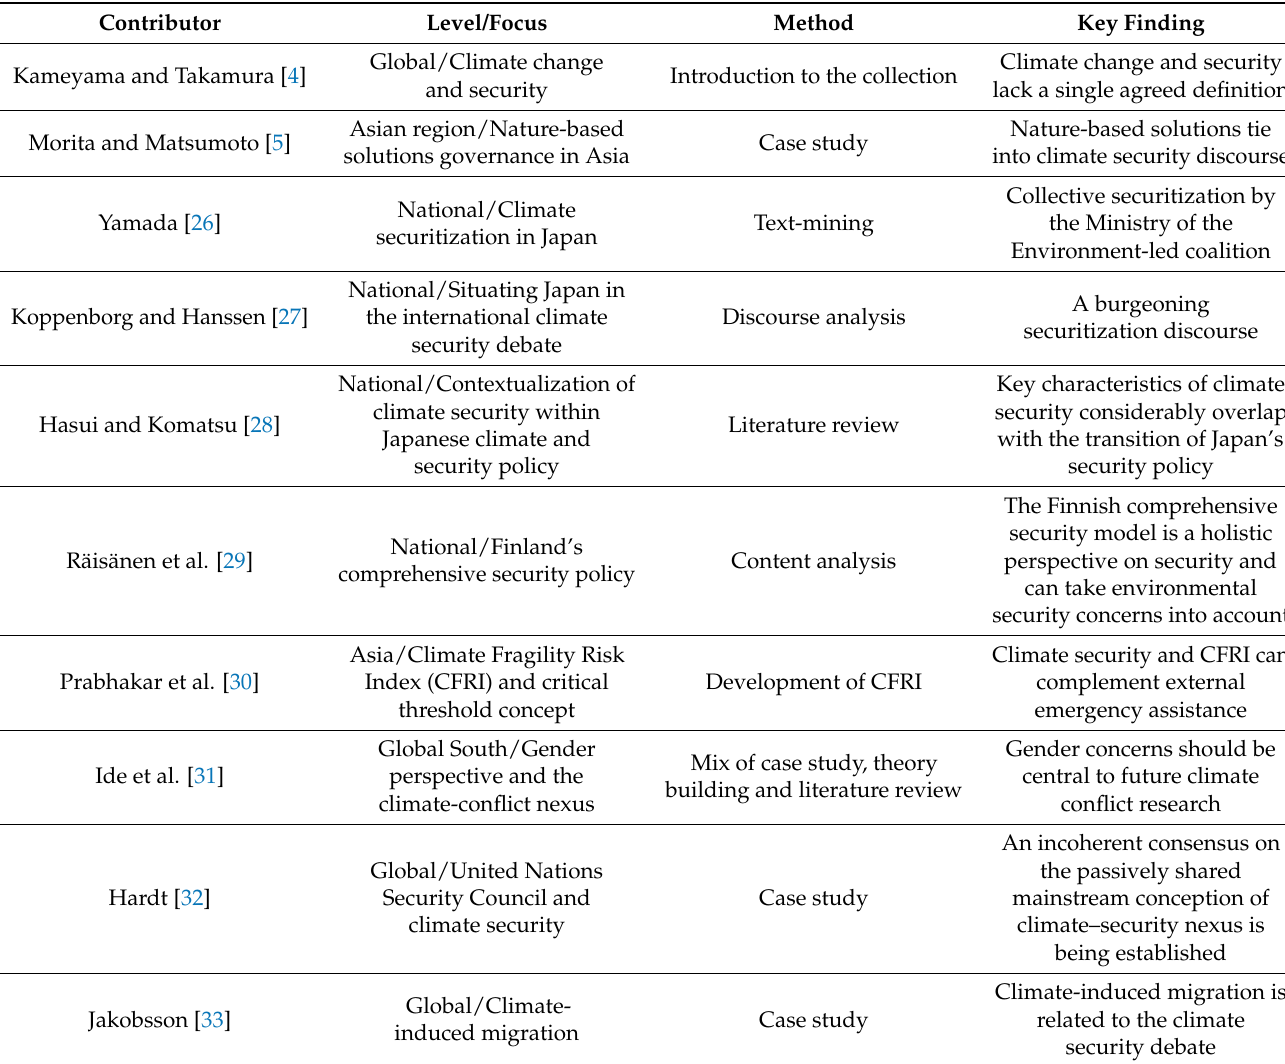
Table 1. Key findings from the second research